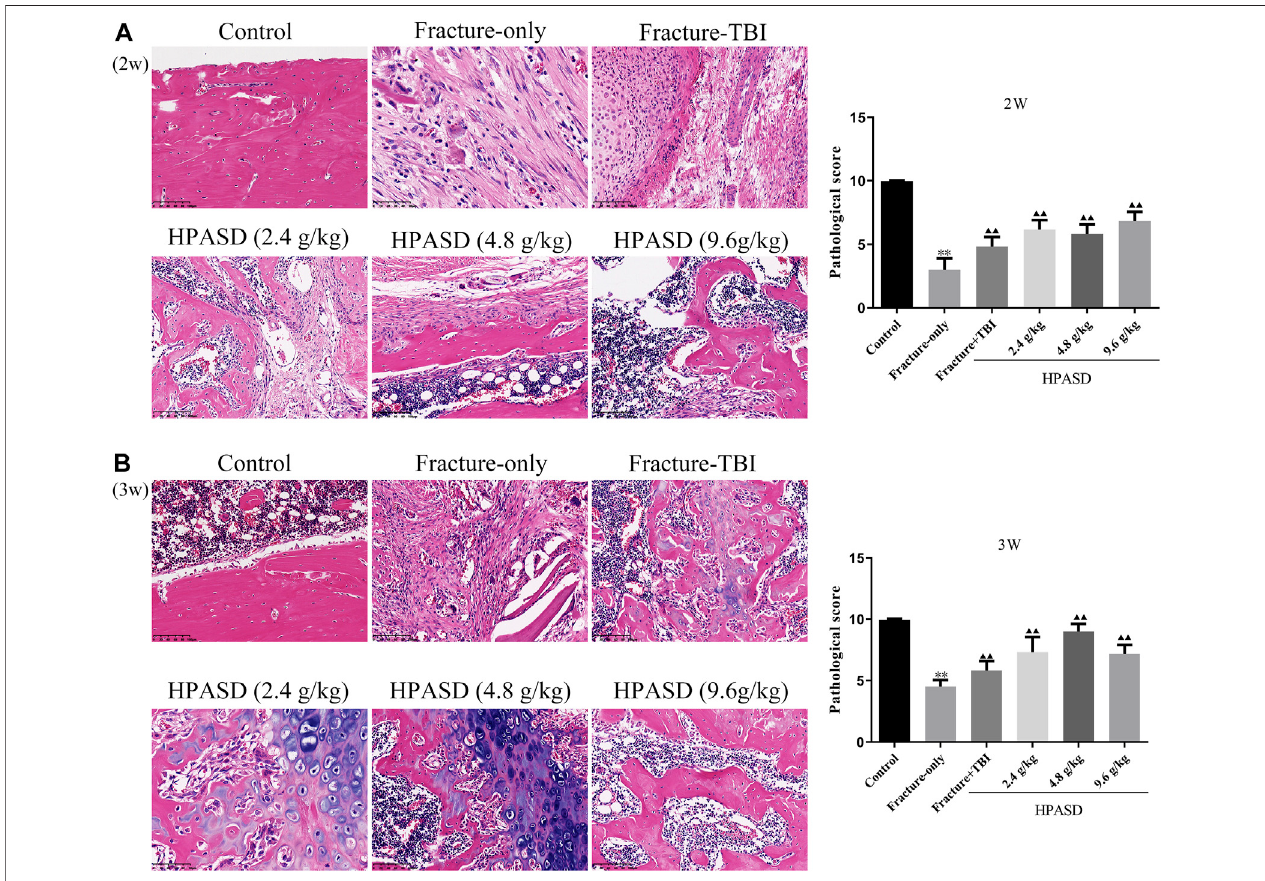
FIGURE5| Thehistologicalanalysisofthefracturehealingintheratmodeloftraumaticbraininjury.HEstainingforevaluatinghealingoftibiashaftfractureatthe (A) secondand (B) thirdweeksafterHPASDtreatment(Scalebar:100 μ m).* p < 0.05 ,** p < 0.01 vs.controlgroup; ▲ p < 0.05 , ▲▲ p < 0.01 vs.Fracture-onlygroup[unpaired Student ’ s